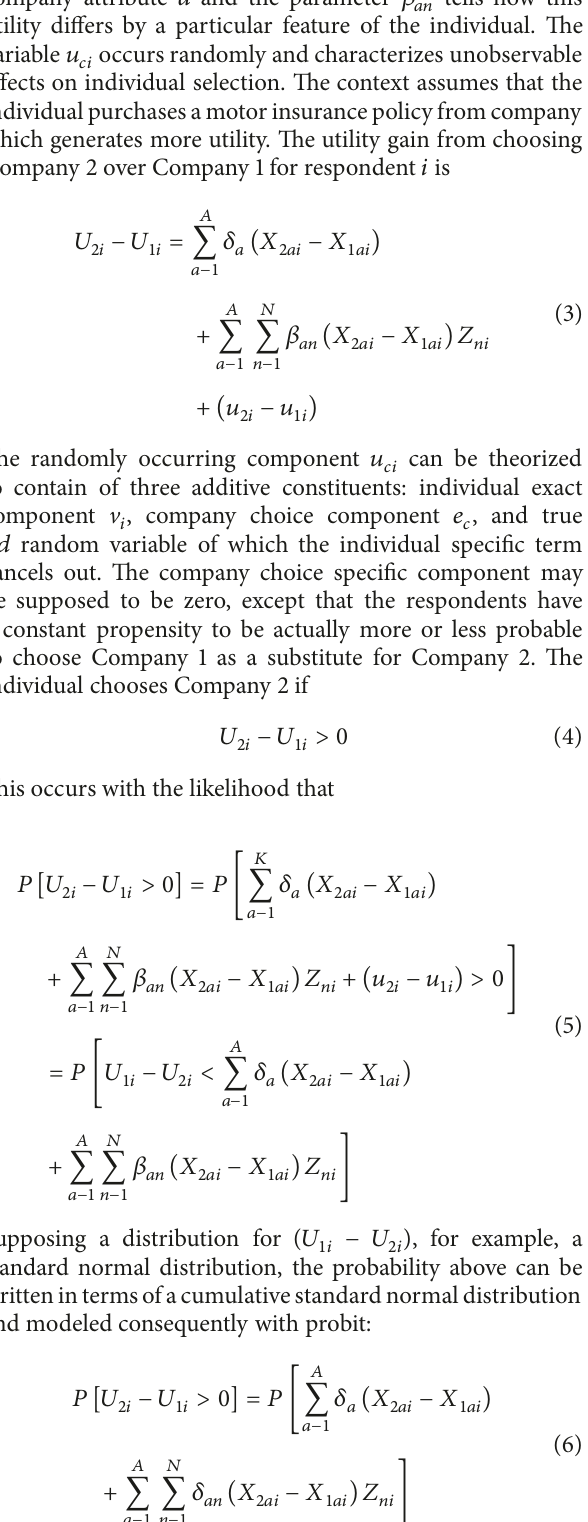
Table 1: Attributes and corresponding